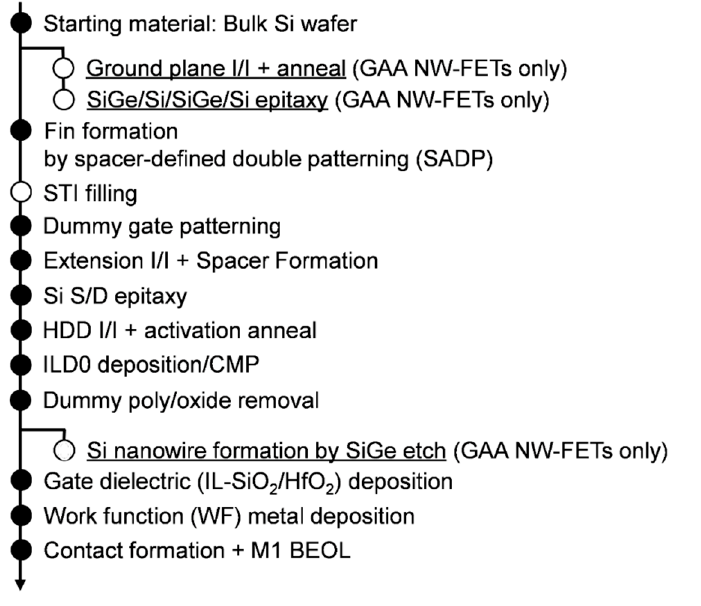
Figure 2. Fabrication process flow in FinFET and GAA NW-FET.